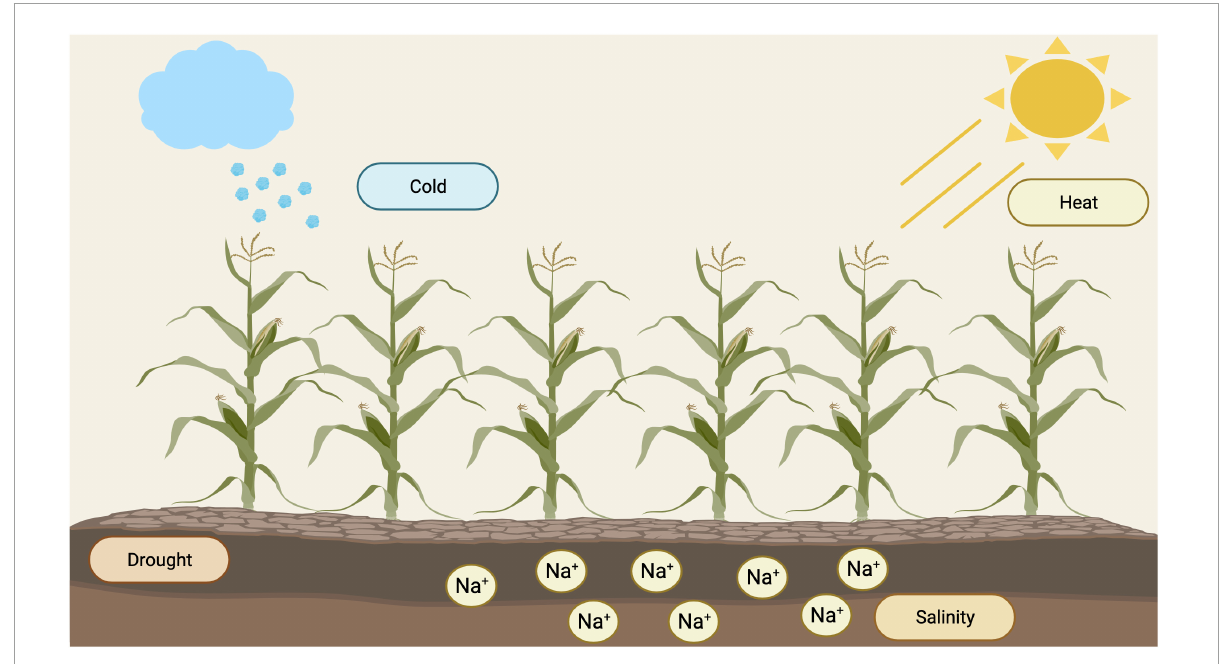
FIGURE1 Types of abiotic stresses that affect yield productivity in maize (https://biorender.com; accessed on 21 February 2022).